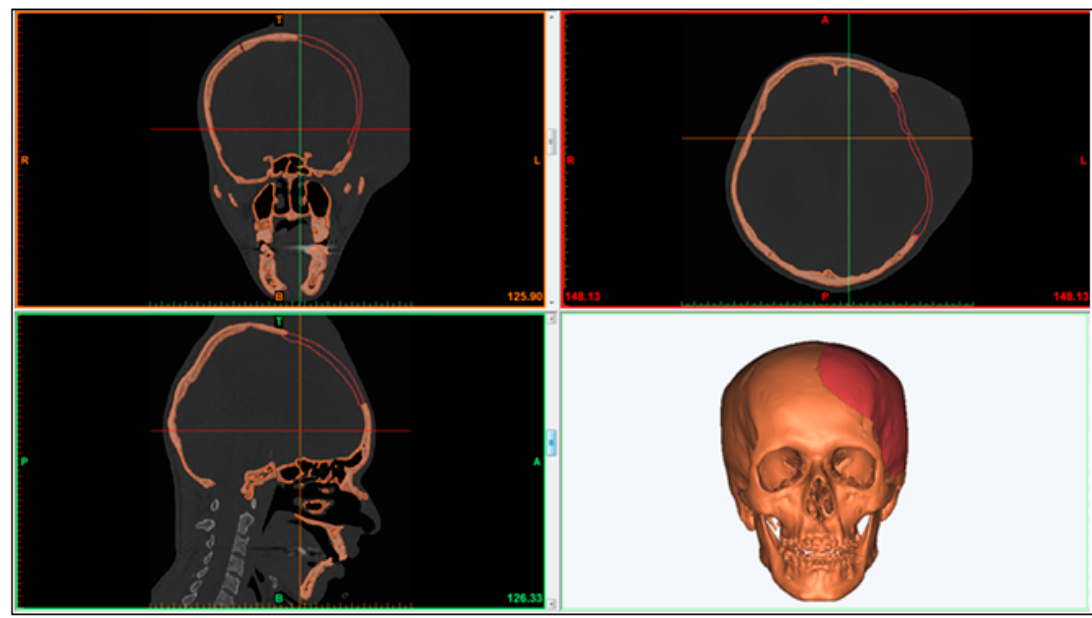
Figure 4. Precise fitting of custom built cranial implant on the deformed skull region.